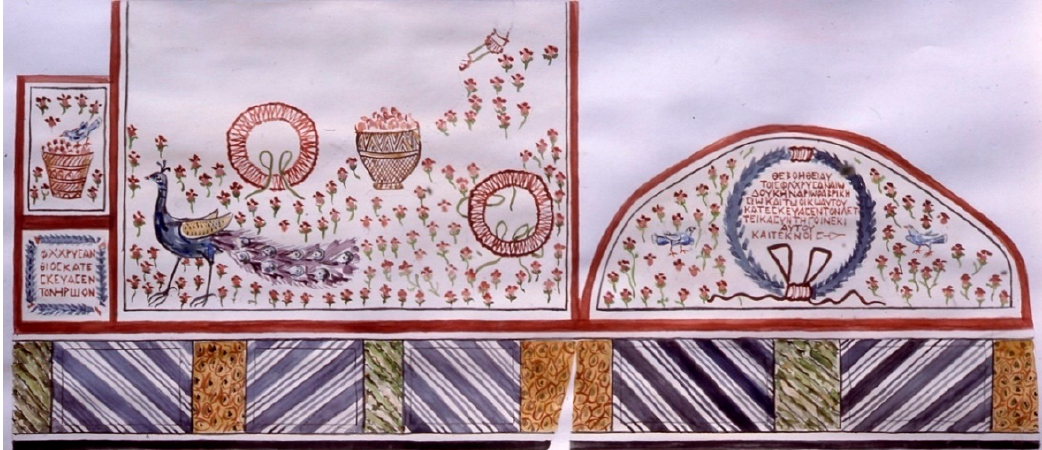
Figure 5. Sardis, Tomb of Chrysanthios (Tomb 76.1, Appendix A.1), painting of east and south walls. © Archaeological Exploration of Sardis/President and fellows of Harvard College.